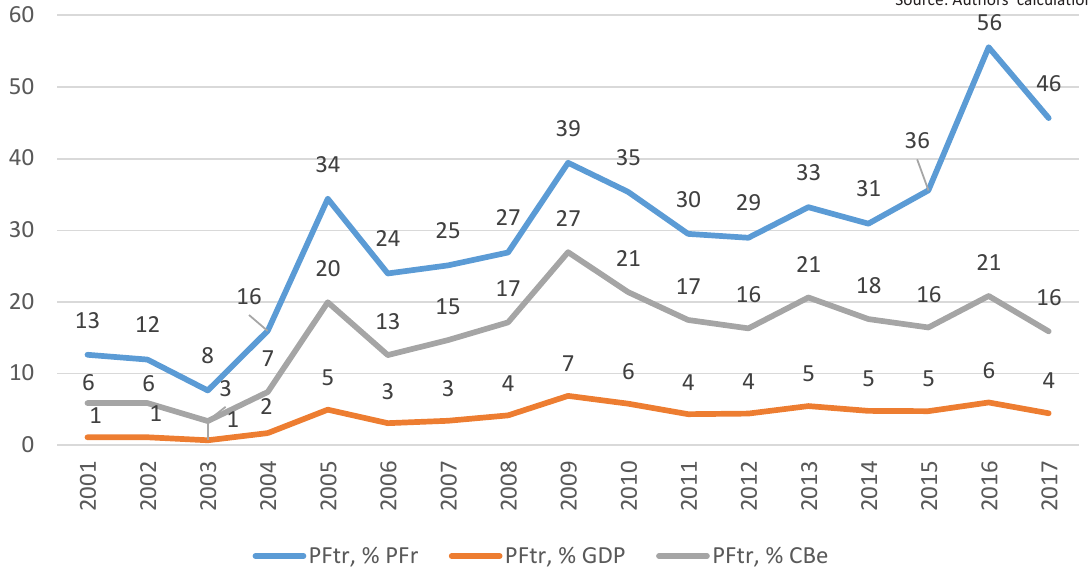
Figure 2. Indicators of transfers in